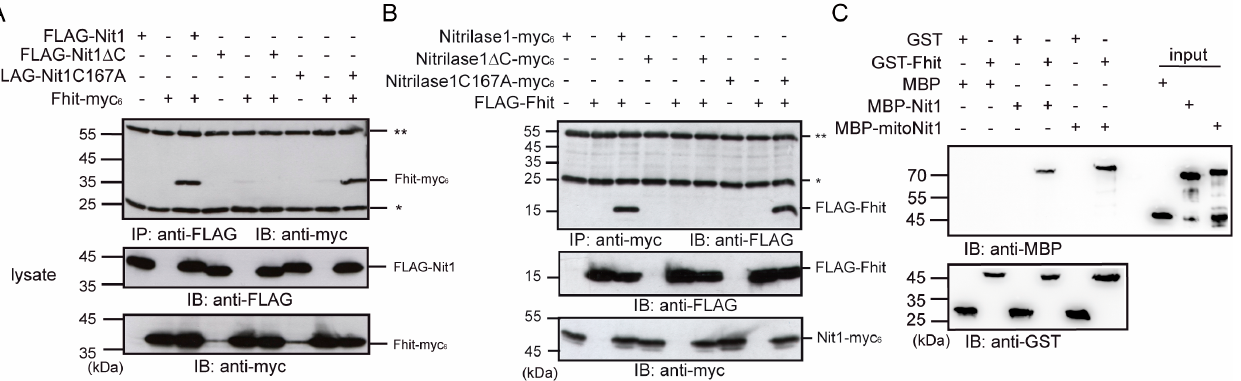
Figure A2. Gel filtration chromatograms of molecular weight standard proteins separated on a Superdex™200-HR column.